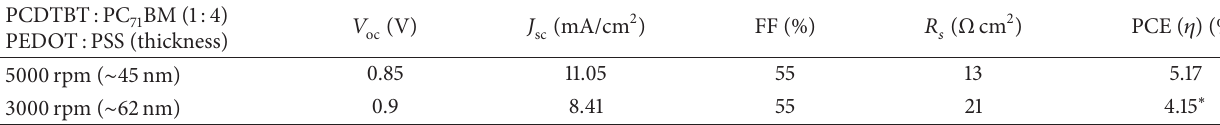
BM ratios (1: 4) prepared in o-DCB with different thickness of PEDOT: PSS 71